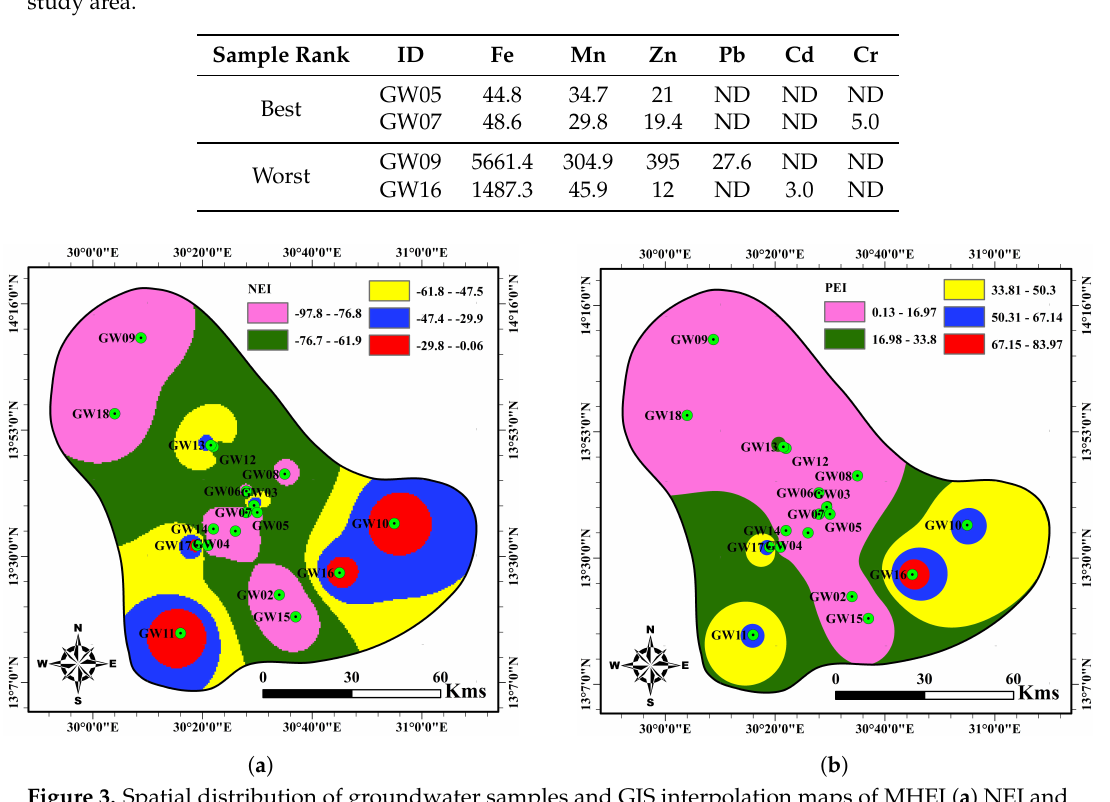
Figure 3. Spatial distribution of groundwater samples and GIS interpolation maps of MHEI ( a ) NEI and ( b ) PEI values in the study area.